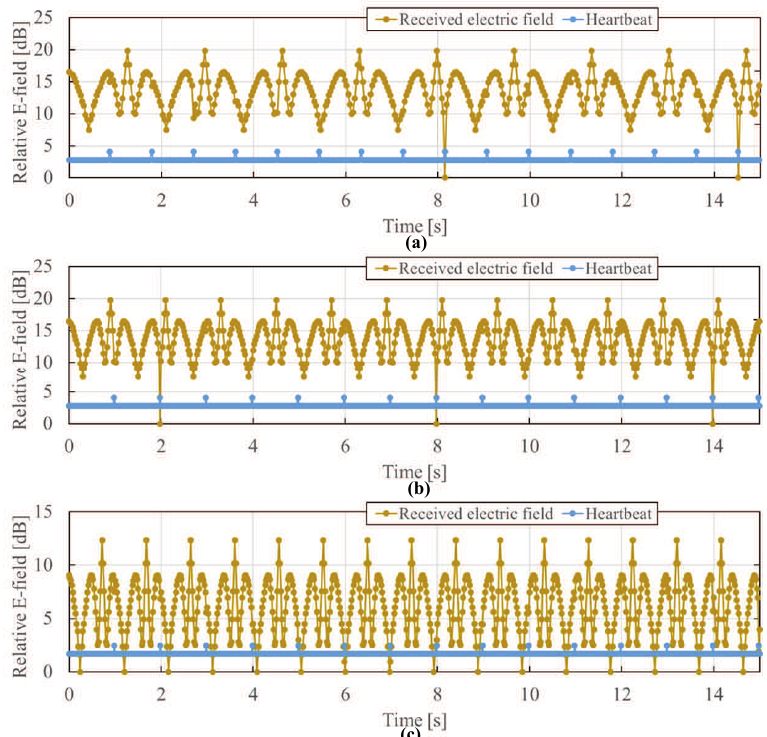
Figure 7. Time waveform of received electric field at Sensor C. The yellow line is the electric field detected by the Sensor C, and the blue line is the assumed heartbeat timing. The peak generated by the diastole and systole of the heart is 1 dB or more at the assumed heartbeat position. The other positive and negative peaks correspond to the positions where the body movement direction switches from left to right or from right to left. Body movement frequency: ( a ) 0.6 Hz, ( b ) 0.8 Hz, ( c ) 1.0